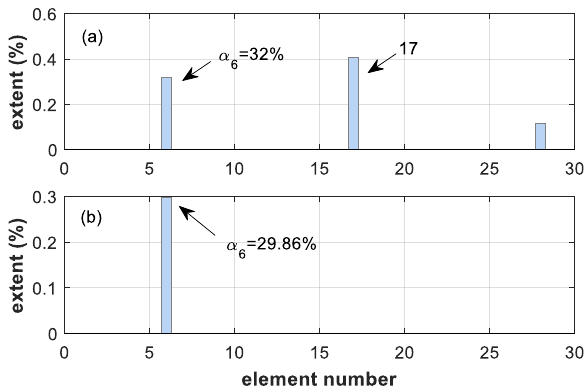
Figure 6. Damage identification results of damage case A at a 3% level of noise, with an iterative Tikhonov solution: ( a ) CMSE method; ( b ) RCMSE method.